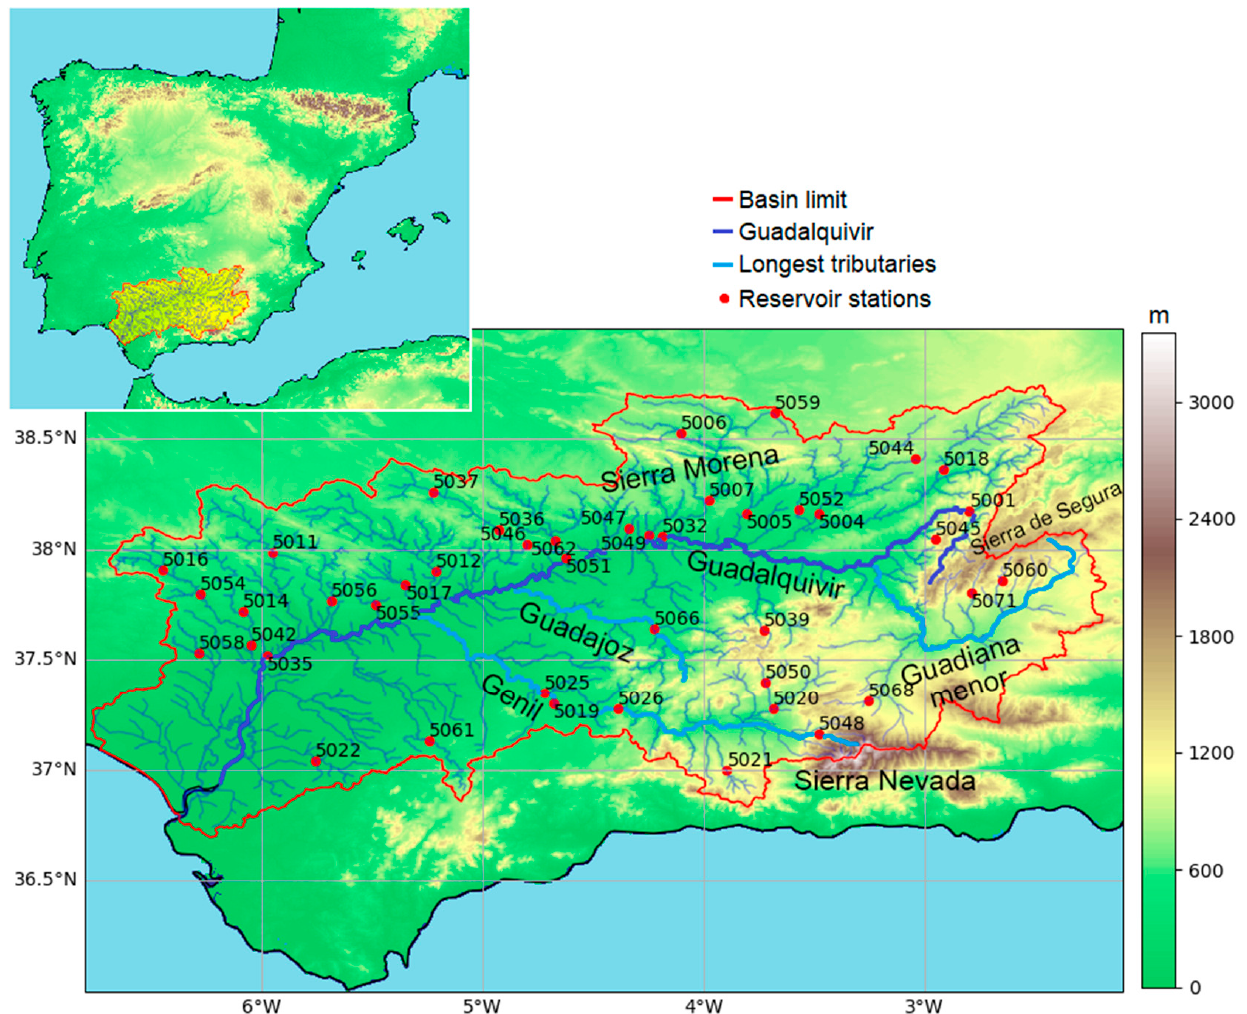
Figure 1. Location of the Guadalquivir River Basin in the southern Iberian Peninsula. Designation of reservoir stations and their spatial distribution in the Guadalquivir River basin. Altitude in meters is represented with a color scale, and longest tributaries and main mountain ranges are located in the map.